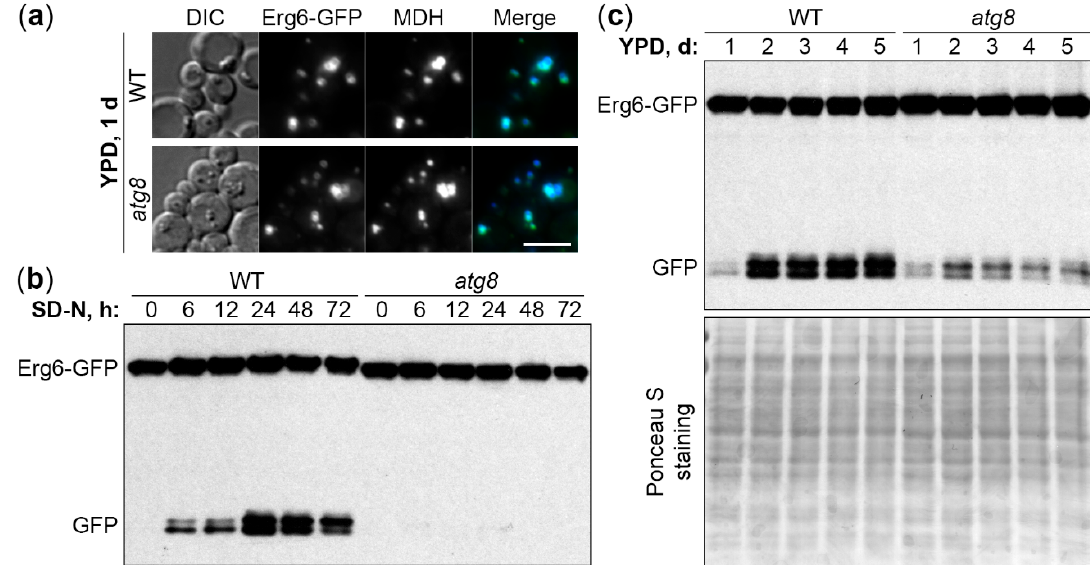
Figure 1. Komagataella pha ffi i is a good model for both N-starvation and S-phase lipophagy. ( a ) K. pha ffi i Erg6-GFP co-localizes with MDH-stained LDs in both WT and atg8 cells. DIC: Di ff erential interference contrast. Scale bar, 5 µ m. ( b ) Atg8 is essential for N-starvation lipophagy. Cells were normalized in SD-N at OD 600 1, and an equal volume of culture (1 mL) was processed at all time-points for both strains to nullify the di ff erential growth (Erg6-GFP dilution) e ff ects in SD-N medium (loading control is not applicable). ( c ) Atg8 is only partially required for S-phase lipophagy. Since biomass slightly decreased during the time-course in S-phase, equal biomass (1 OD 600 ) was taken at all time-points for both strains. Ponceau S staining was used as a loading control for S-phase